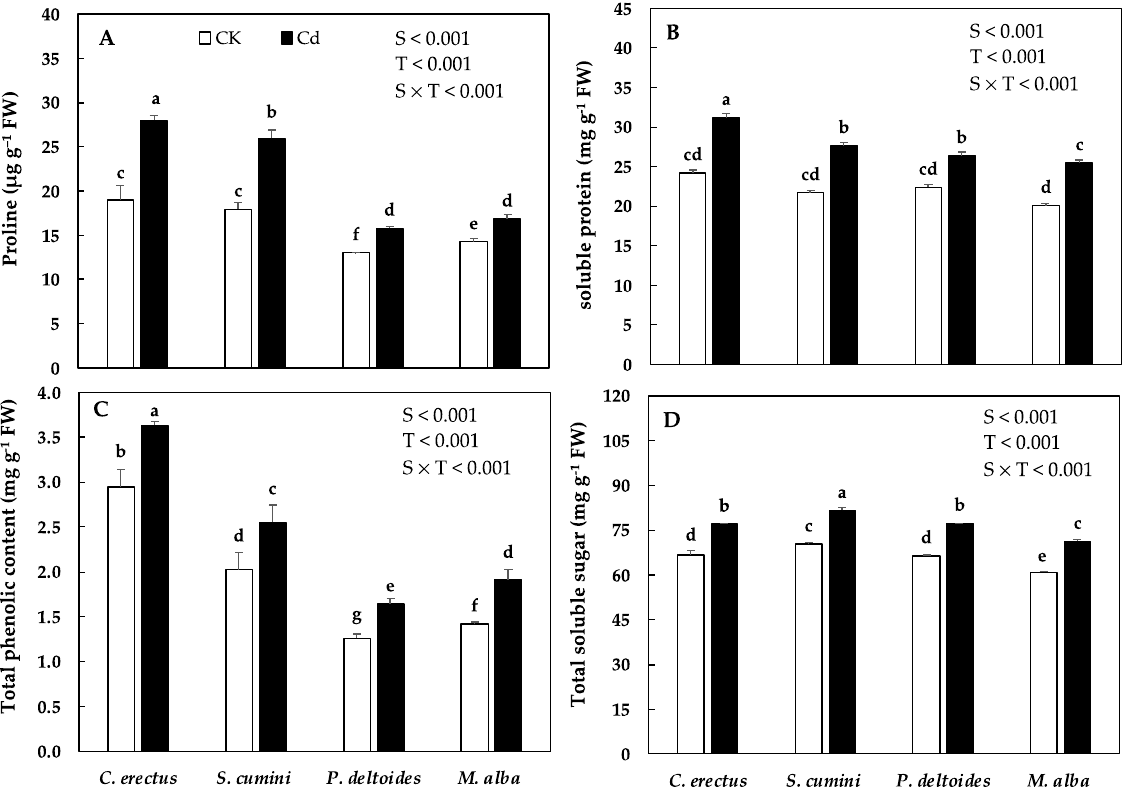
Figure 2. Mean values of ( A ) proline, ( B ) soluble protein, ( C ) total phenolic contents and ( D ) total soluble sugar under CK and Cd treatments. Small letters depict significant differences between treatment means (n = 5).